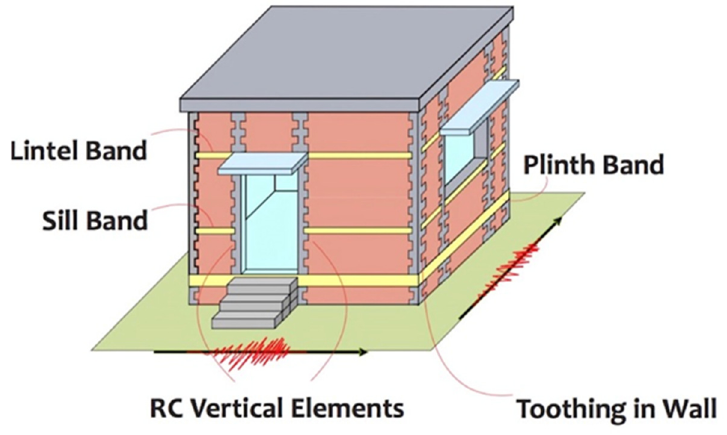
Figure 9. Concept of confined masonry for seismic resistance.